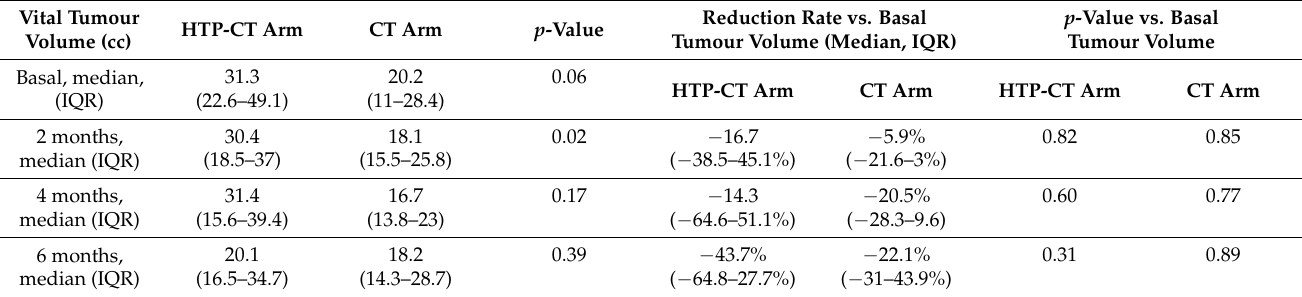
Table 4. Median (IQR) basal and post-treatment tumour volume at 2-months (HTP-CT arm n = 14; CT arm n = 17), 4-months (HTP-CT arm n = 12; CT arm n = 16) and 6-months (HTP-CT arm: n = 10; CT arm: n = 12) follow-up and median (IQR) vital tumour volume reduction rate versus